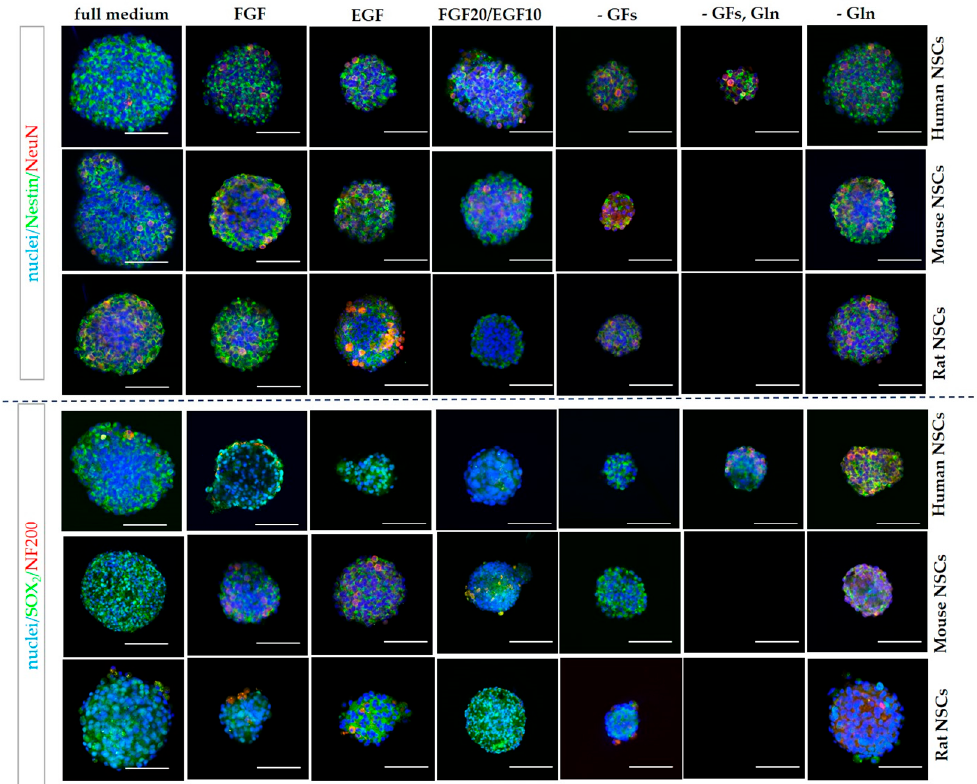
Figure 13. Neural differentiation of human, mouse, and rat NSCs in 3D conditions. Nestin, NeuN, SOX2 , and NF200 immunofluorescence analysis. Cell culture conditions: 5% O 2 , 5% CO 2 , 37 °C. Scale: 50 µm.